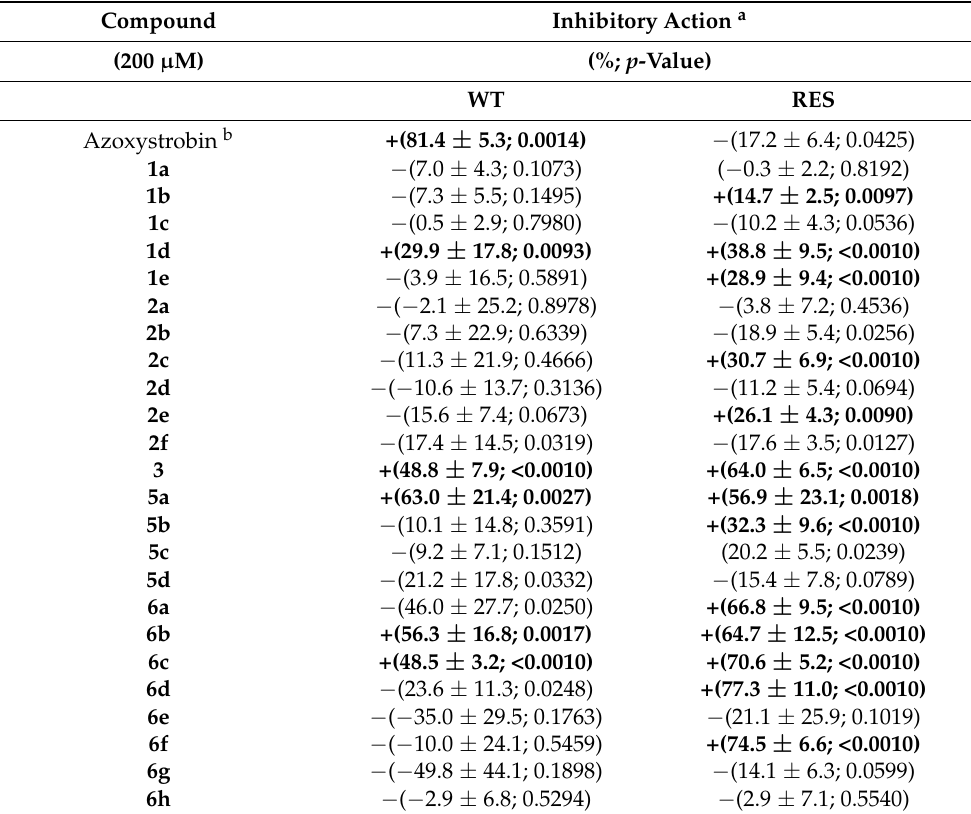
Table 1. Inhibitory action of the tested compounds on the cyt bc1 function by measurements of the mitochondrial NADH:cyt c oxidoreductase